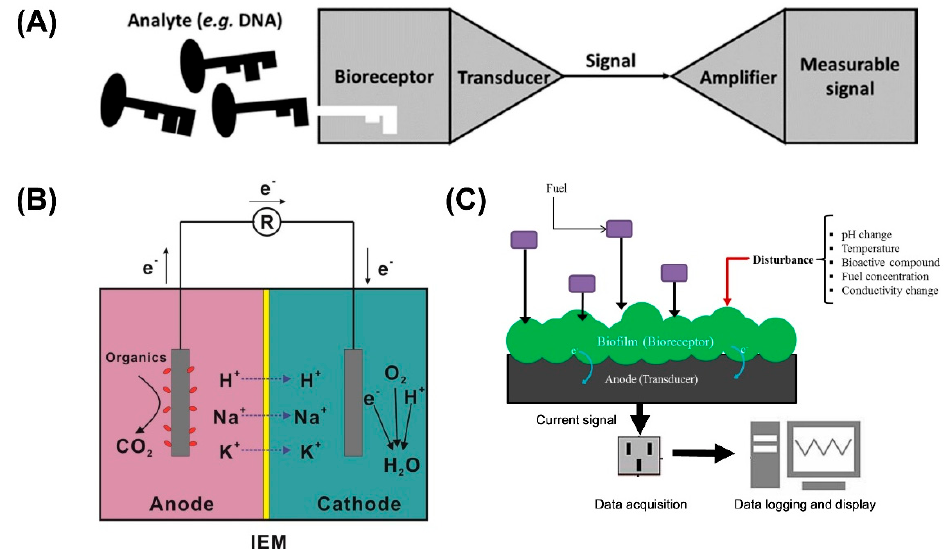
Figure 1. Schematic diagrams of ( A ) a biosensor [20], ( B ) a dual-chamber microbial fuel cell (MFC) and ( C ) an MFC-based biosensor.